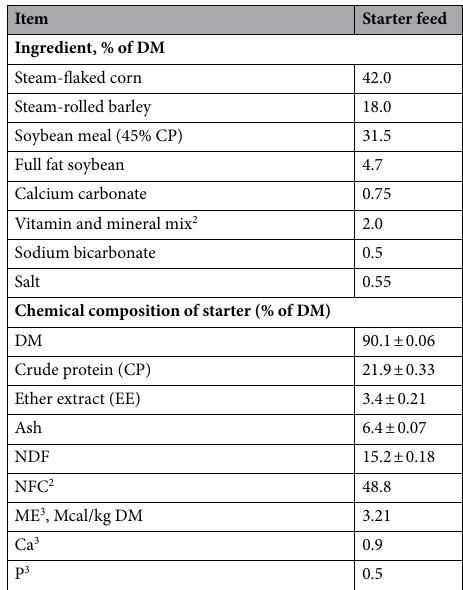
Table 1. Ingredients, and chemical composition of the experimental starter. 1 Contained per kg of supplement: Vit A (IU) = 1,300,000, Vit D3 (IU) = 360,000, Vit E (IU) = 12,000, Ca (g) = 240, Mg (g) = 67, Zn (mg) = 20,000, Cu (mg) = 4290, I (mg) = 200, Co (mg) = 100, Mn (mg) = 10,000, Se (mg) = 80. 2